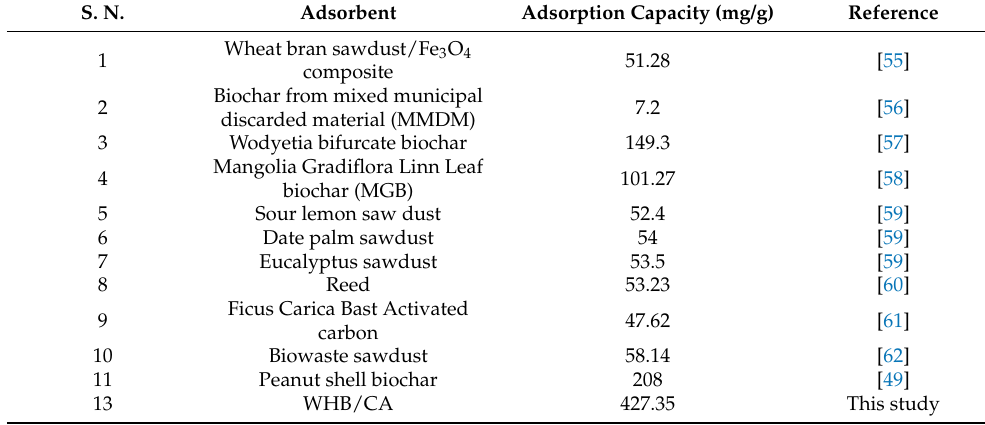
Table 4. Comparison of maximum adsorption capacities of biochar prepared from different